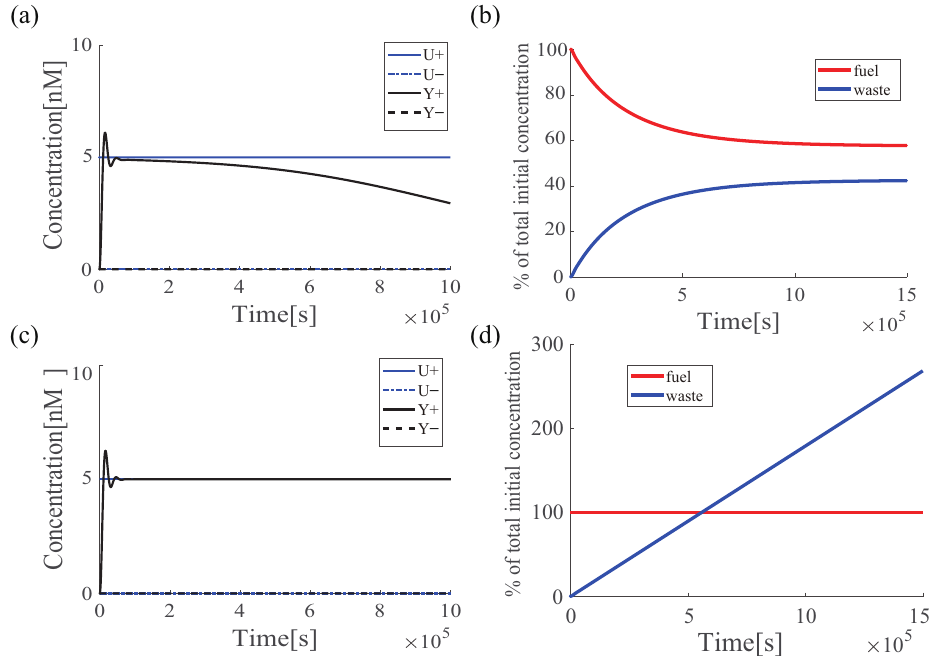
Figure 2. Performance degradation of the DNA-PI controller. All reaction rates are the same as those in Figure 1. Only the input U + was changed to 5 nM. ( a ) Time-course change in concentration of input U ± (blue line) and output Y ± (black line); ( b ) time-course change in total concentration of fuel (red line) and waste (blue line) strands; ( c ) time-course change in concentration of input U ± (blue line) and output Y ± (black line) when fuel strands are not consumed; and ( d ) time-course change in total concentration of fuel (red line) and waste (blue line) strands when fuel strands are not